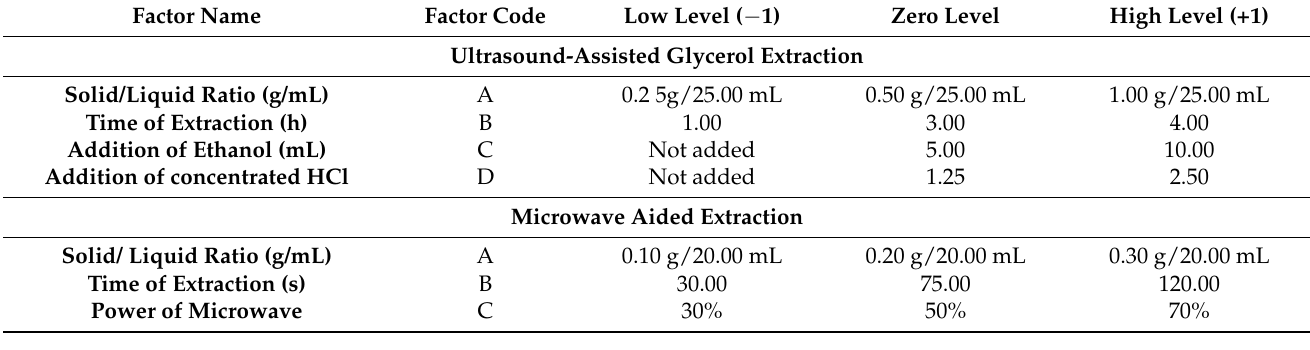
Table 2. Summary of the factorial design for factors that affected the extraction of red onion scales by ultrasound-assisted glycerol extraction protocol and microwave-assisted extraction.